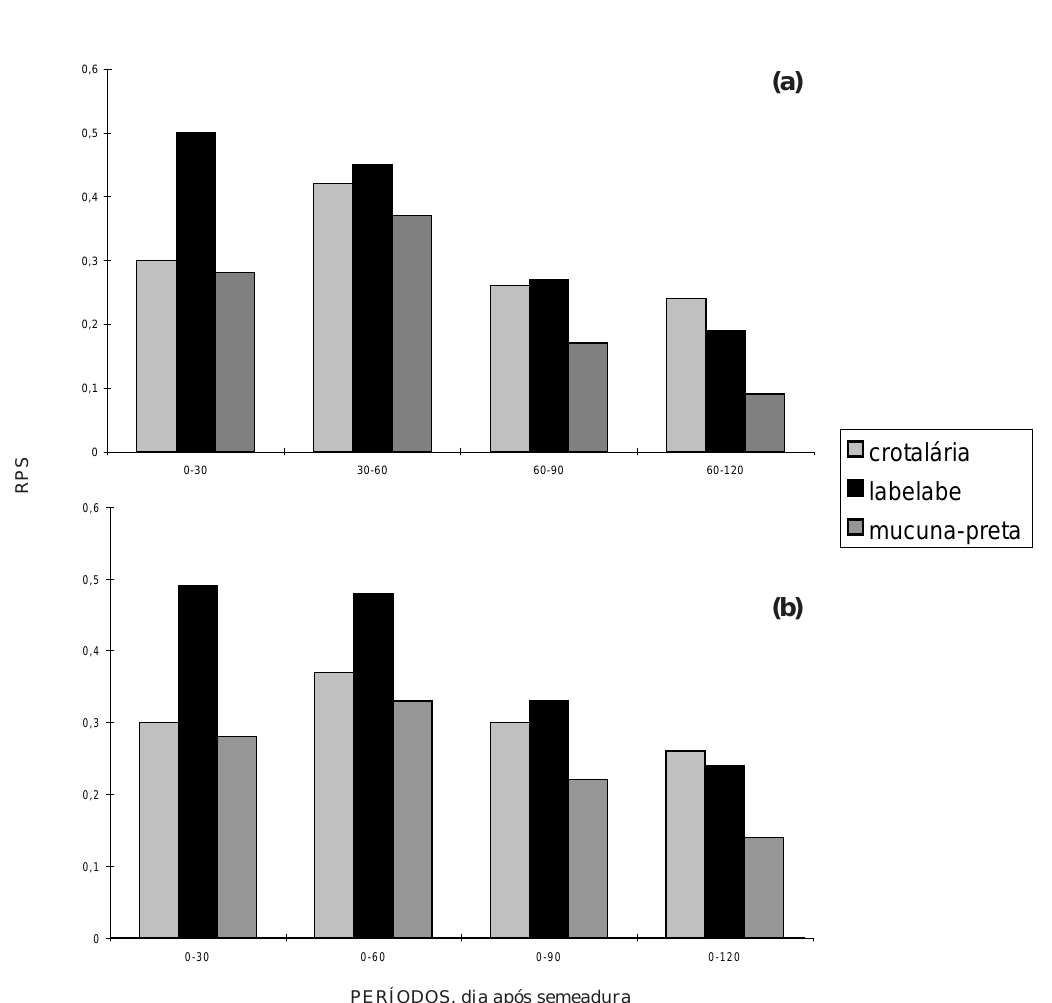
Figura 1. Razão de perdas do solo para três leguminosas, (a) para períodos isolados e (b) para períodos